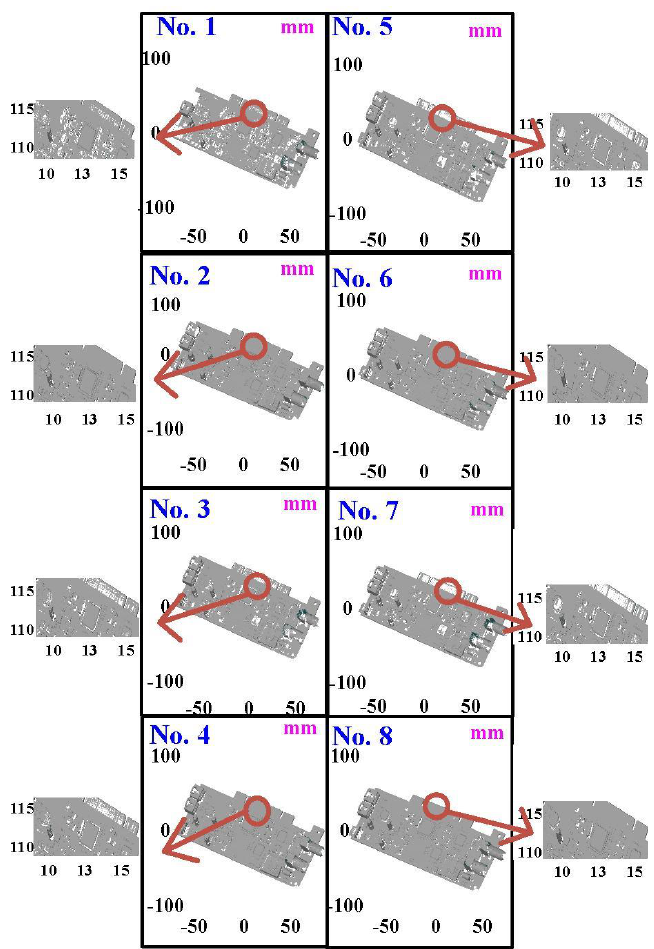
Figure 17. Measurement results of the circuit board that was not sprayed with a mixture of ethanol and TiO 2 powder.